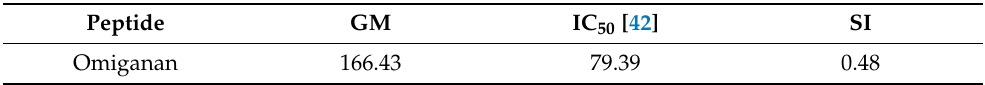
Table 2. Geometric mean of the MIC values (GM), IC 50 , and calculated Selectivity Index (SI)